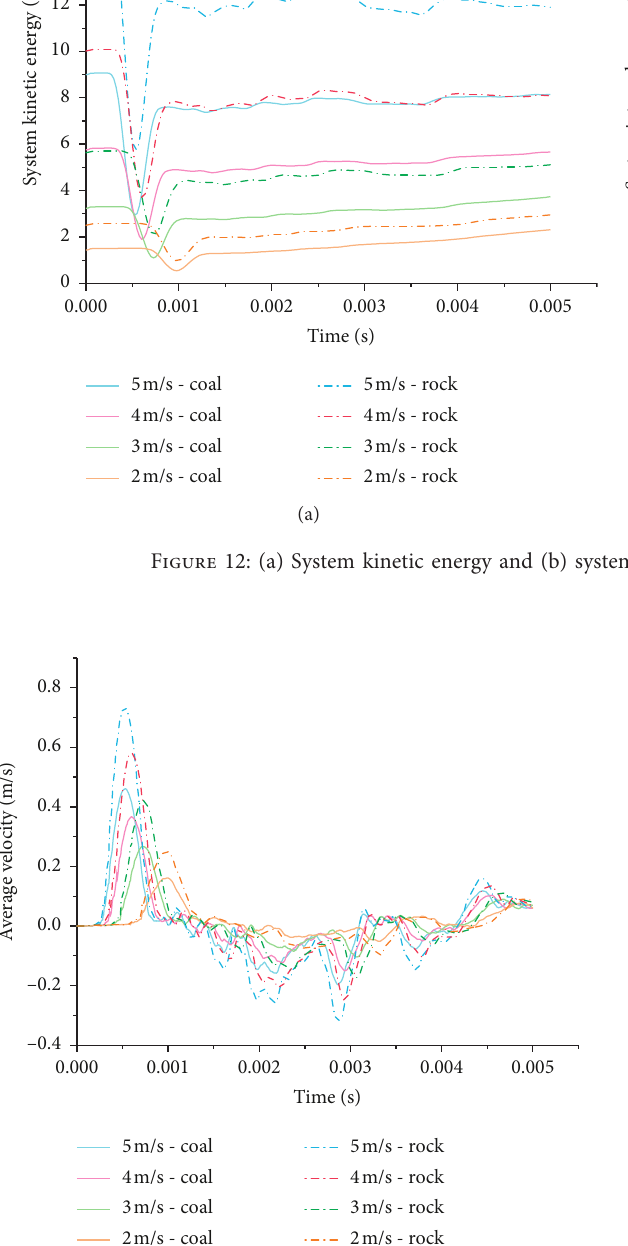
Figure 13: Average velocity in the tail beam collision contact zone under different impact